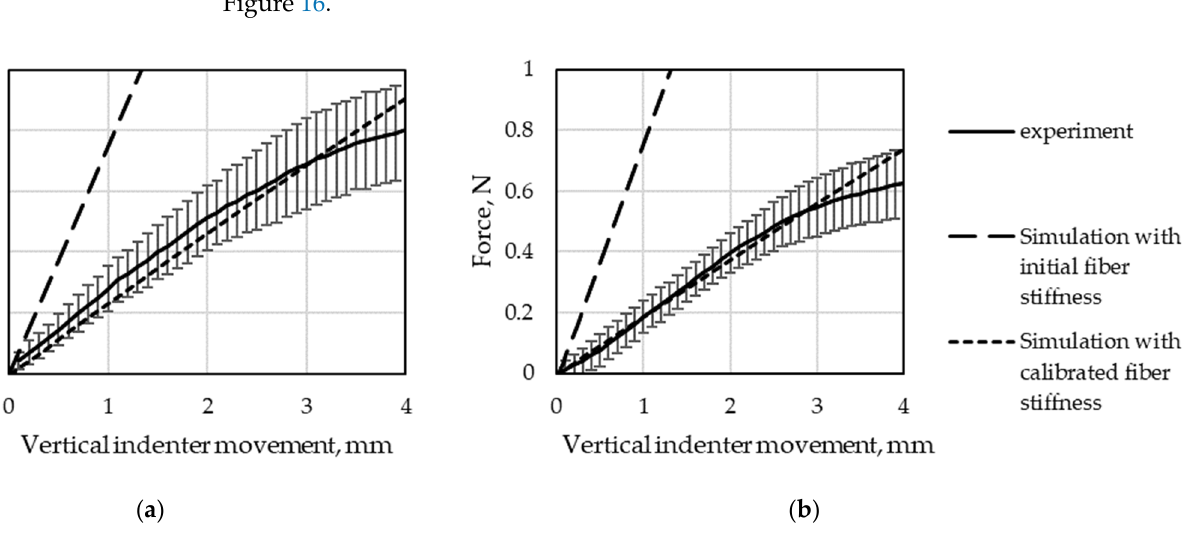
Figure 16. Four-point-bending test results from the simulation and experiment of FRC specimens for ( a ) Var1 and ( b ) Var2. ( a ) Var1 and ( b )